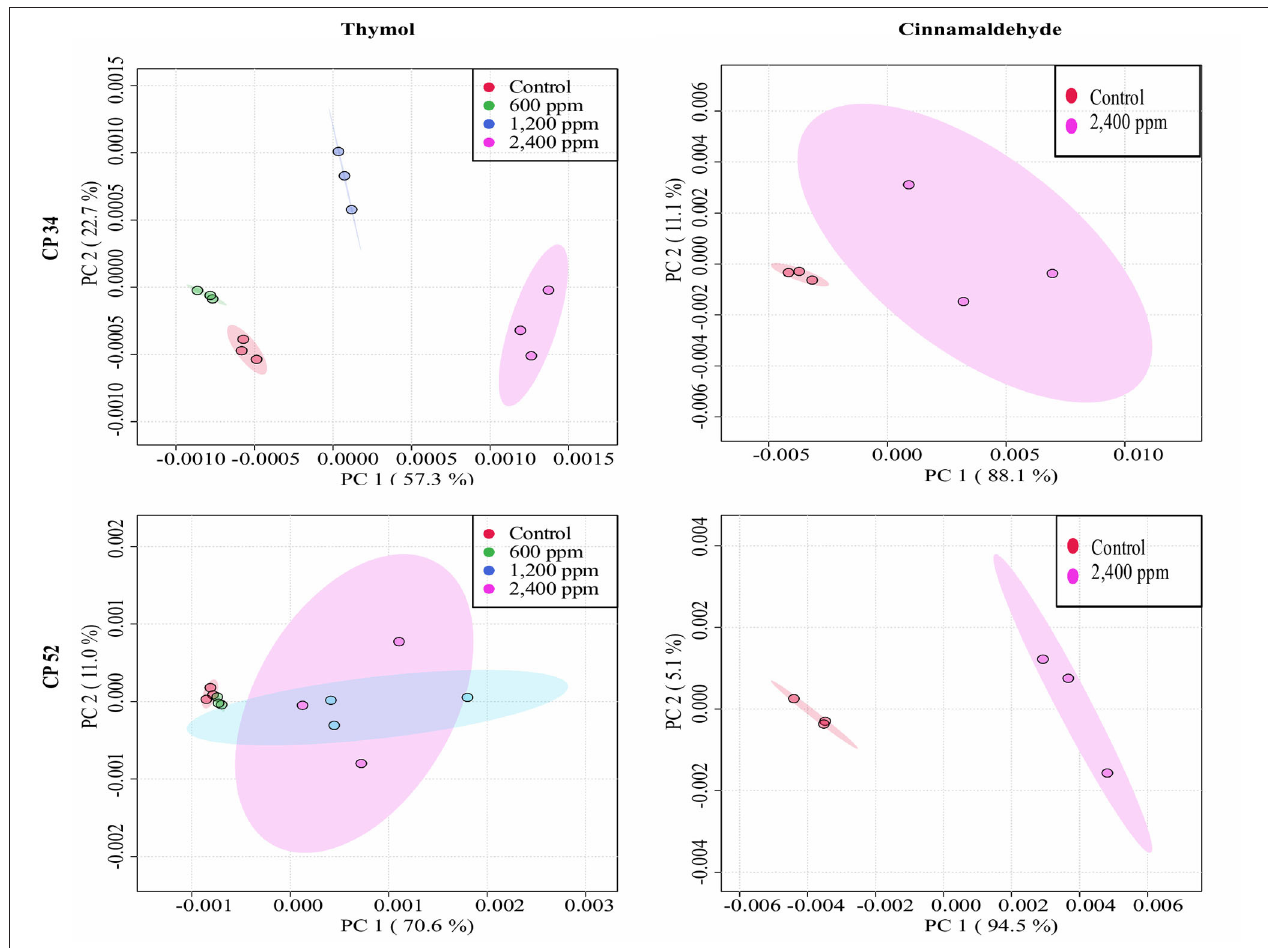
FIGURE 5 | Principal component analysis (PCA) from ASCII data of the FTIR absorbance spectra of the selected windows obtained for each isolate tested of C. perfringens after the exposure to different concentrations of thymol and cinnamaldehyde (green shaded areas and points, ½ MBC low ; blue shaded areas and points, MBC low ; light blue shaded areas and points, MBC high ; purple shaded areas and points, 2MBC high ) and without compound (red shaded areas and points, control) for 90min at room